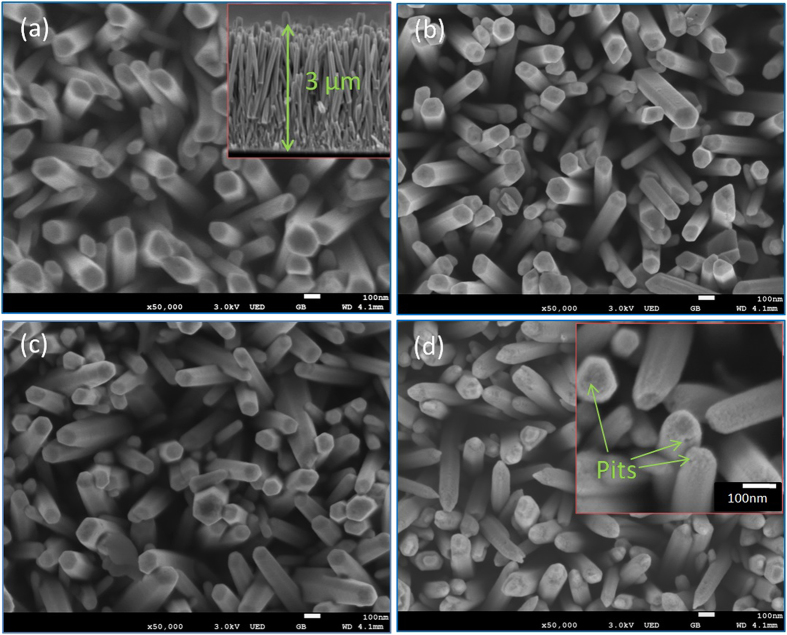
FESEM images of (a) pristine ZnO and N doped ZnO NRAs with different implantation doses: (b) N/ZnO-1 (1.25 × 1014 ions/cm2), (c) N/ZnO-3 (5 × 1014 ions/cm2), (d) N/ZnO-5 (5 × 1015 ions/cm2).